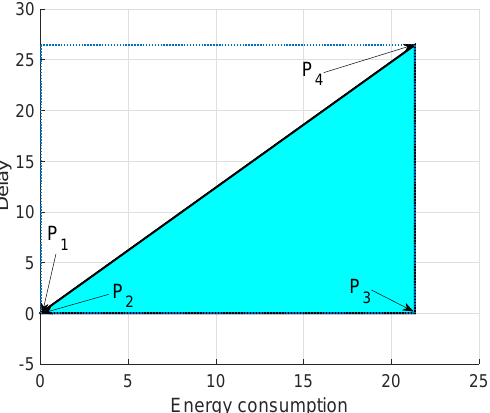
Figure 20. Feasible region for energy consumption and delay using